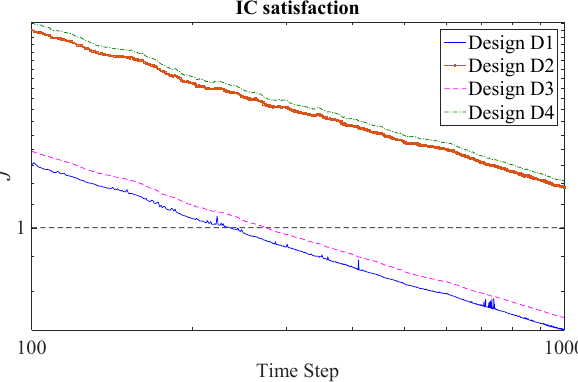
Figure 9. Identification time required for satisfaction of IC for an FCC reactor-regenerator system when inputs are produced from designs D1–D4. n Jc